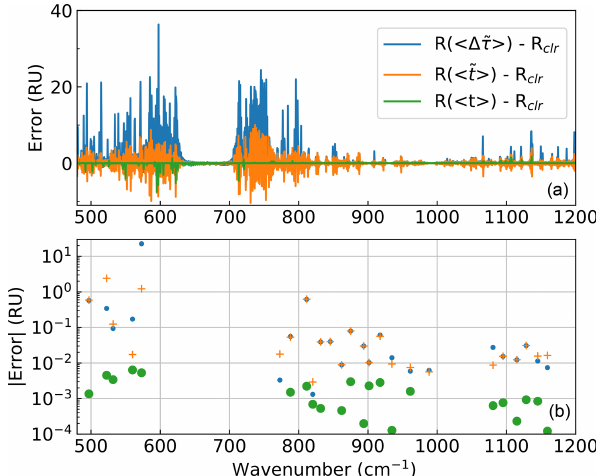
Figure 4. Radiance errors (1RU = 1mW/(m 2 srcm − 1 )) for dif- ferent methods of approximating the radiance at a resolution of 0.5cm − 1 . Approximate radiances are computed using mean perfect-resolution layer optical depths R( (cid:104) (cid:49) e τ (cid:105) ) , mean surface-to- layer perfect-resolution transmittances R( (cid:104) e t (cid:105) ) , or mean surface-to- layer transmittances after convolution to the instrument R( (cid:104) t (cid:105) ) ; av- erages are over 0.5cm − 1 (a) or over microwindows (b) . Approx- imate radiances are compared to simulated radiances at 0.5cm − 1 resolution ( R clr ), which are averaged over microwindows in (b)